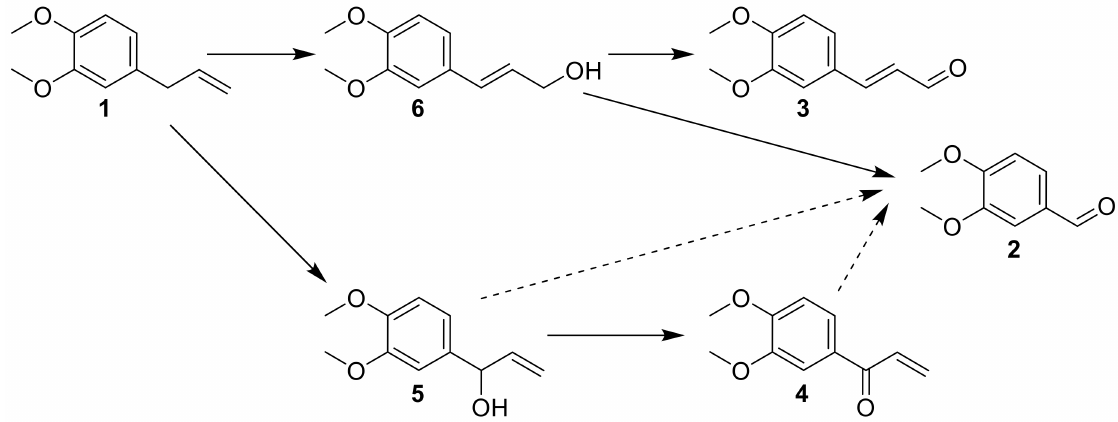
Figure 15. The proposed mechanism after data interpretation from intermediates